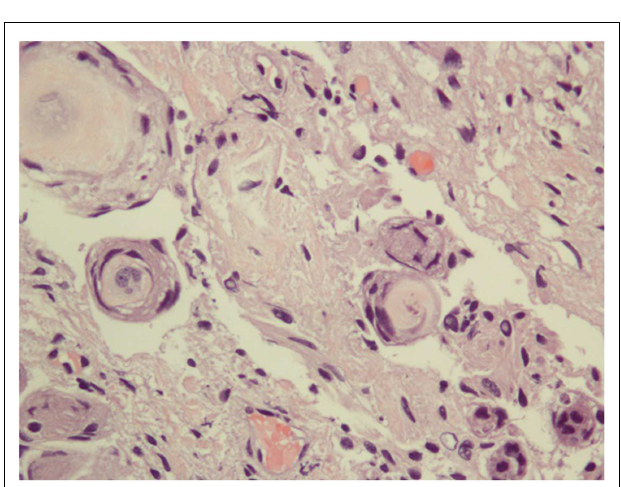
FIGURE 2 |The specimen consists of uniform, benign-appearing, spindle-shaped cells with whorl formations containing hyalinized material with some degeneration . In time, with calcification, these whorls will progress to psammoma bodies classically observed in meningiomas.